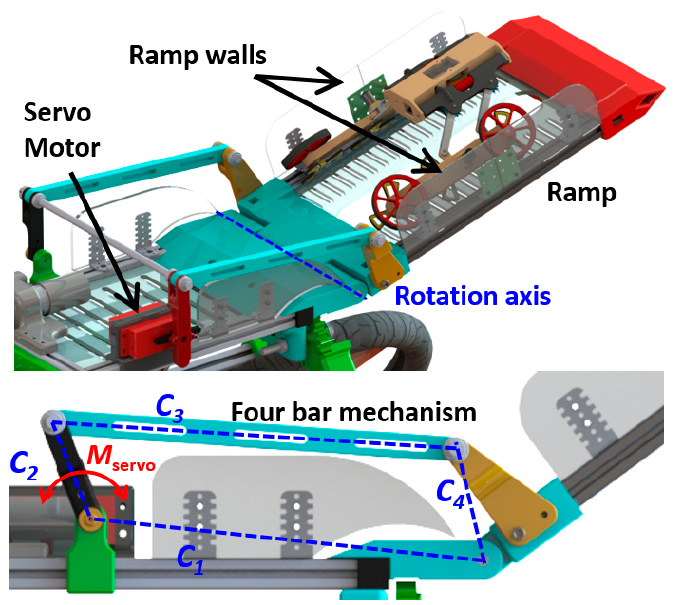
Figure 7. The ramp is actuated by a motor aligned with its rotation axis.